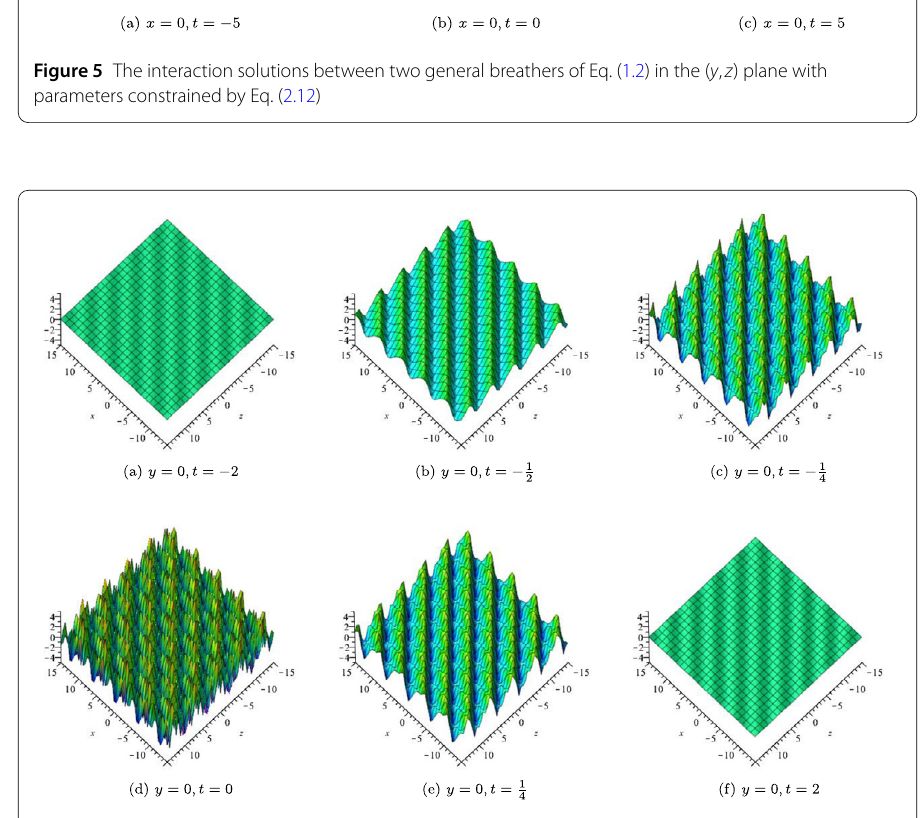
Figure 6 The interaction solution between two general breathers of Eq. (1.2) in the ( x , z ) plane with parameters constrained by Eq.